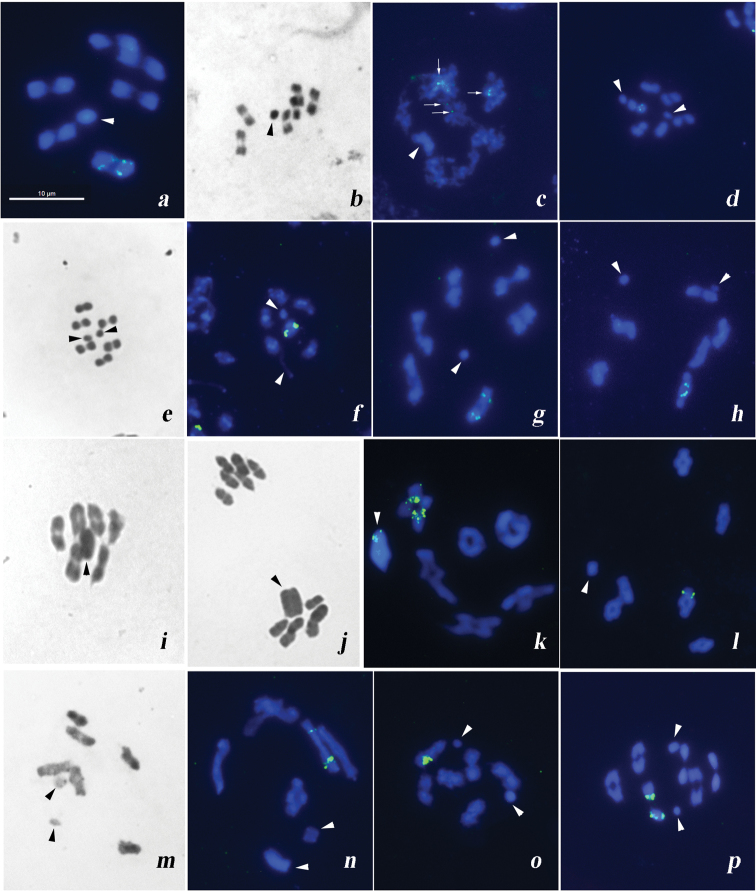
Male meiotic chromosomes of lace bug species after standard Schiff-Giemsa staining (b, e, i, j, m) and FISH with 18S rDNA and (TTAGG)n telomeric probes (a, c, d, f-h, k, l, n–p). aAcalyptacarinata metaphase I (MI) b, cAcalyptamarginata MI (b) late prophase (c); 18S rDNA FISH signals on several bivalents are indicated by arrows dAgrammaatricapillum MI e, fCatoplatuscarthusianus MI (e) late prophase (f) gLasiacanthahermani prophase I/MI transition hDictylaplatyoma prophase I/MI transition i, g, kDerephysia (Paraderephysia) longispina MI (i) anaphase I (j) diakinesis (k) lDictyonotastrichnocera prometaphase I m, nOncochilasimplex prophase I to MI transition oTingis (Tropidocheila) reticulata prometaphase I pTingis (Neolasiotropis) pilosa. Sex chromosomes are indicated by arrowheads. Scale bar: 10 μm.